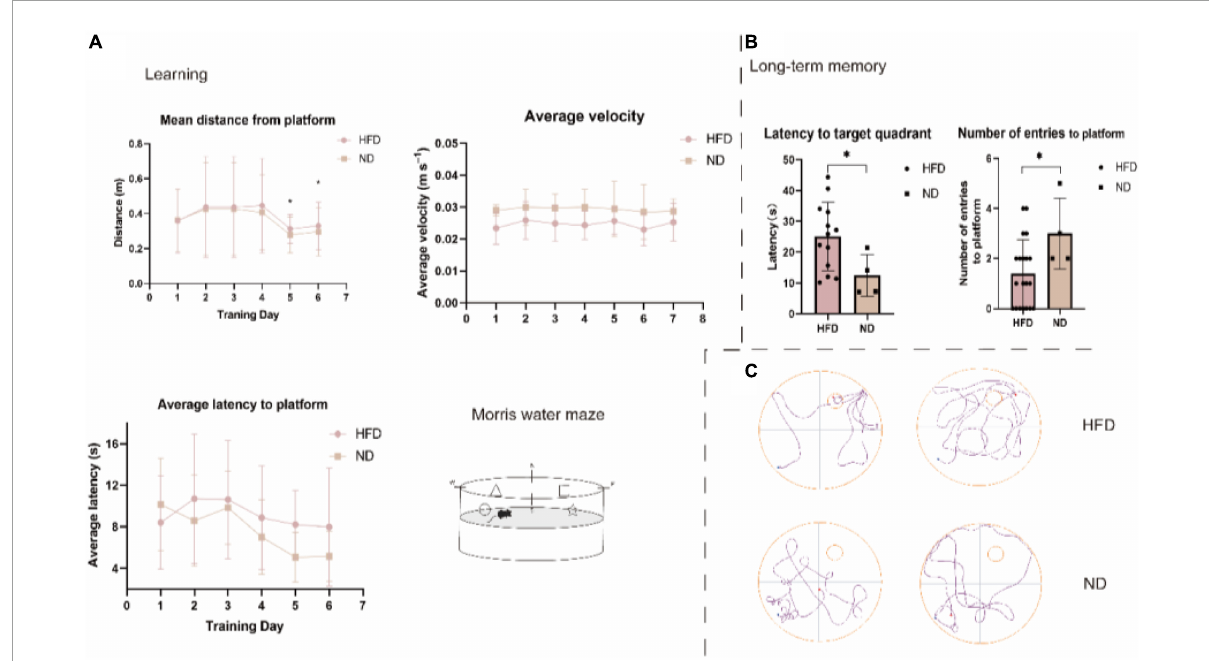
FIGURE2 High-fat diet impairs spatial learning and memory in aged C57BL/6 mice. Long-term spatial memory assessed via MWM. (A) Learning ability. HFD significantly impacted the mean distance from the platform. ND mice spent more time closer to the platform than HFD mice. HFD mice were significantly different from ND mice on days 5 and 6 ( P = 0.047, P = 0.025, respectively). There were no overall differences in average latency to platform or average velocity. n = 20 (HFD), 4 (ND), (B) Long-term memory. The probe trial revealed an age-related impairment in latency to target quadrant and number of entries to platform, wherein HFD mice were significantly slower to the target quadrant compared to ND mice ( P = 0.049, P = 0.023, respectively). Swimming traces of mice in the probe trial are presented in panel (C). p, two-sample t -test. Mean ± SEM, ∗ p < 0.05 compared with the ND group, HFD, high-fat diet; ND, normal diet.